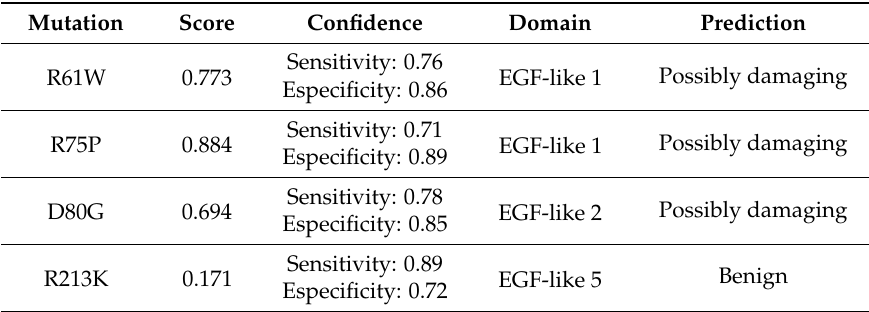
Table 4. Polyphen-2 results and domain localization of the selected mutations. Mutation Score Confidence